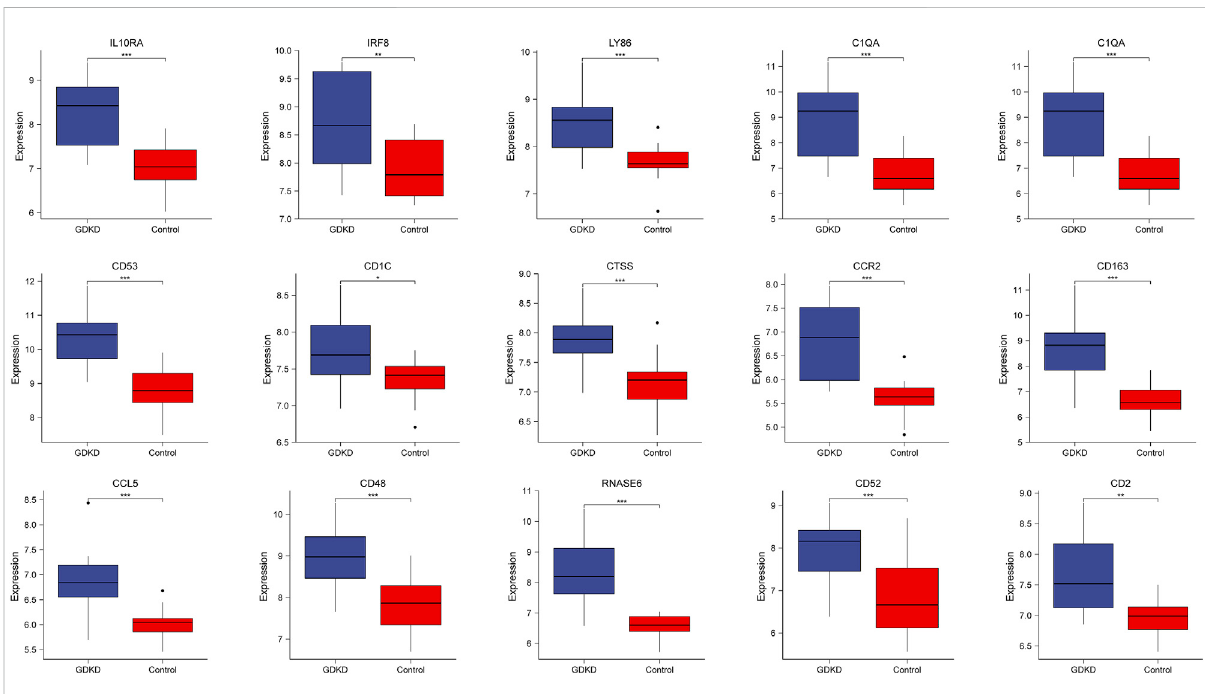
FIGURE 5 mRNA level of hub genes in GSE47183. All hub genes are upregulated in GDKD samples compared with controls. * p < 0.05, * p < 0.01, *** p < 0.001. GDKD: glomerular diabetic kidney